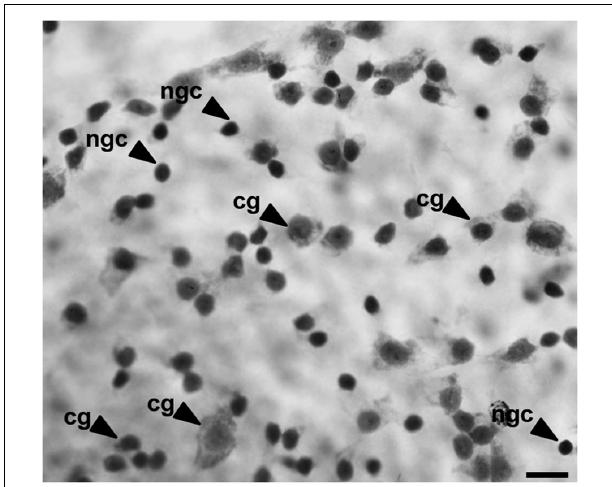
FIGURE 3 | Image of the GCL cells of B. jararaca indicating the morphological criteria used to distinguish ganglion cells (gc), with polygonal cell bodies, from other cell populations (ngc, non-ganglion cell), with a well-defined circular shape and dense nucleus. Scale bar: 10 µ m.